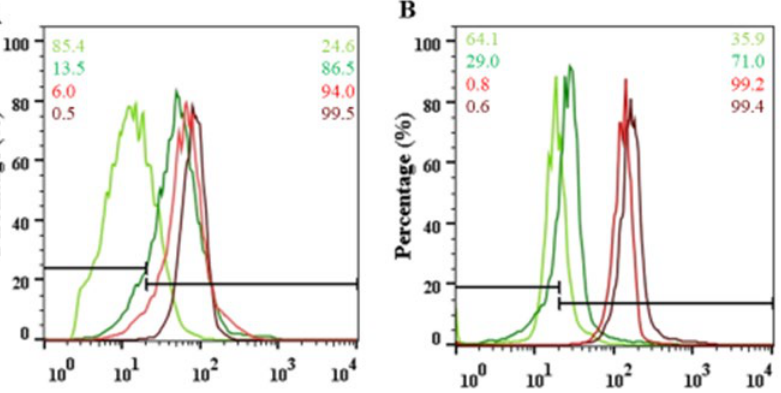
Figure 6. Representative histograms based on FACS (fluorescence-activated cell sorting) analysis on isolated arterial cord RBC-NS (green) and RBC-S (red) populations with (dark green and red) and without (pale green and red line) exposure to Cd 2+ at a concentration of 0.5 ng/μL for 1 h. Quantification of the accumulation of active Caspase-3 ( A ) and the extent of macromolecular damages as followed with the lipid peroxidation marker 4-HNE ( B ) was carried out in glycophorin-positive cell populations. An arbitrary borderline was considered dividing the total RBC population into basal and high-intensity cells.